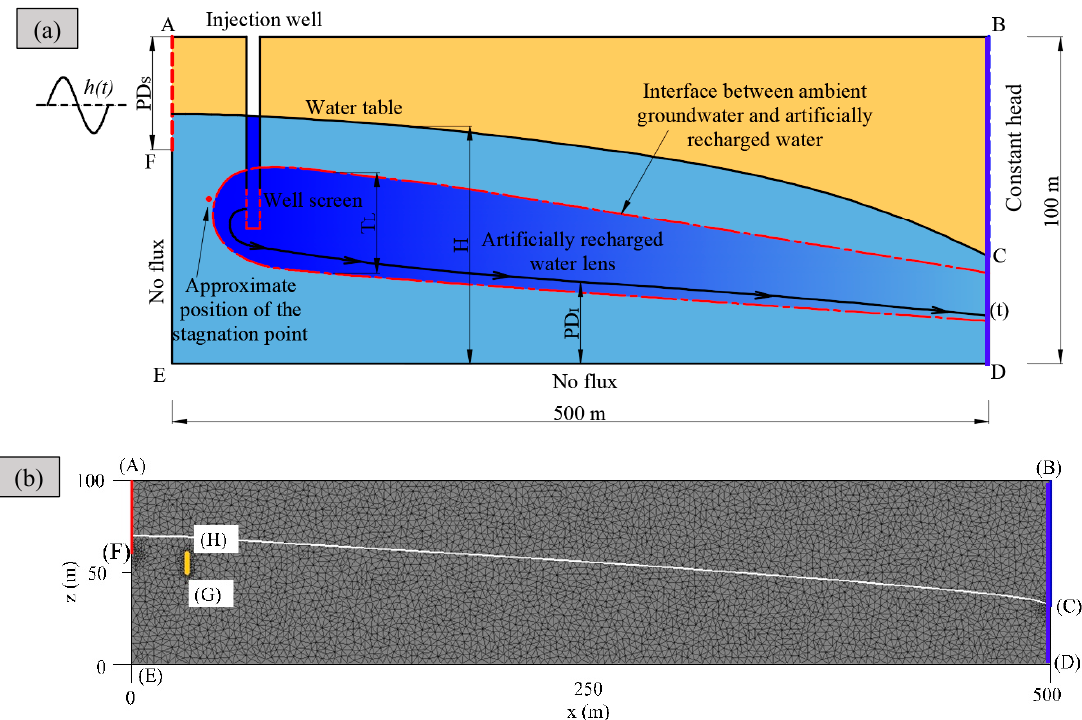
Figure 3. ( a ) Conceptual diagram of the groundwater flows and boundary conditions in an artificially recharged near-bank aquifer exposed to surface water level fluctuations. The PD is the penetration depth of flow path of the artificially recharged water. The surface water penetrates to a depth of PD in the aquifer. TL is the thickness of the artificially recharged water lens. H is the water table. t is the travel time of the artificially recharged groundwater. Parameter h(t) refers to the fluctuating surface water level and the variable head boundary applied to the near-bank aquifer (the red dashed line). The blue dashed line represents the downstream seepage boundary. ( b ) The subdivision of the model domain. The red line refers to the fluctuating surface water level, which was set as a moving boundary. The blue line refers to the seepage boundary. The yellow line refers to the injection well screen and was set as a flux boundary. H is the observation point.